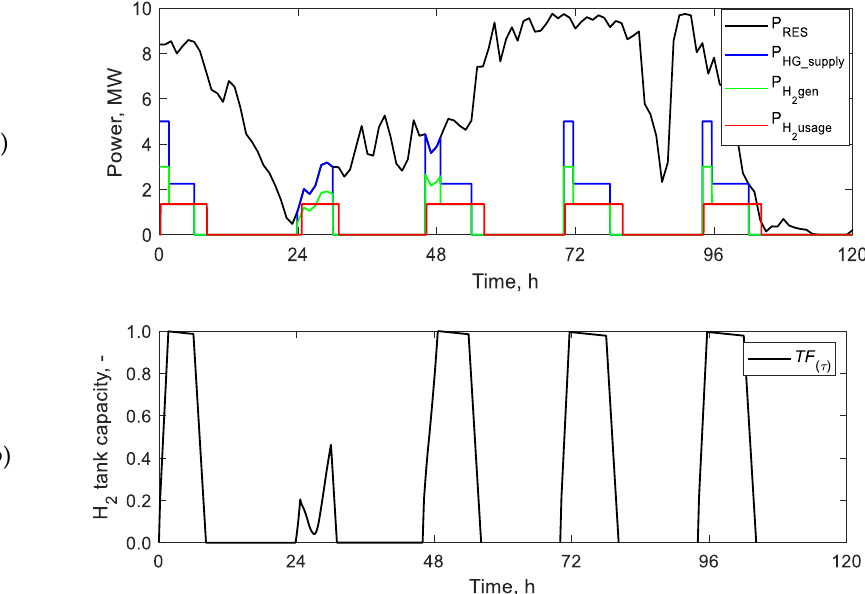
Figure 2. Graphs depicting the computational results for a P2SNG system with a 15 MW wind farm and a 5 MW hydrogen generator integrated with a hydrogen buffer tank (3 MWh for 120 h time operation). ( a ) Power-time series and ( b ) state of charge of the buffer